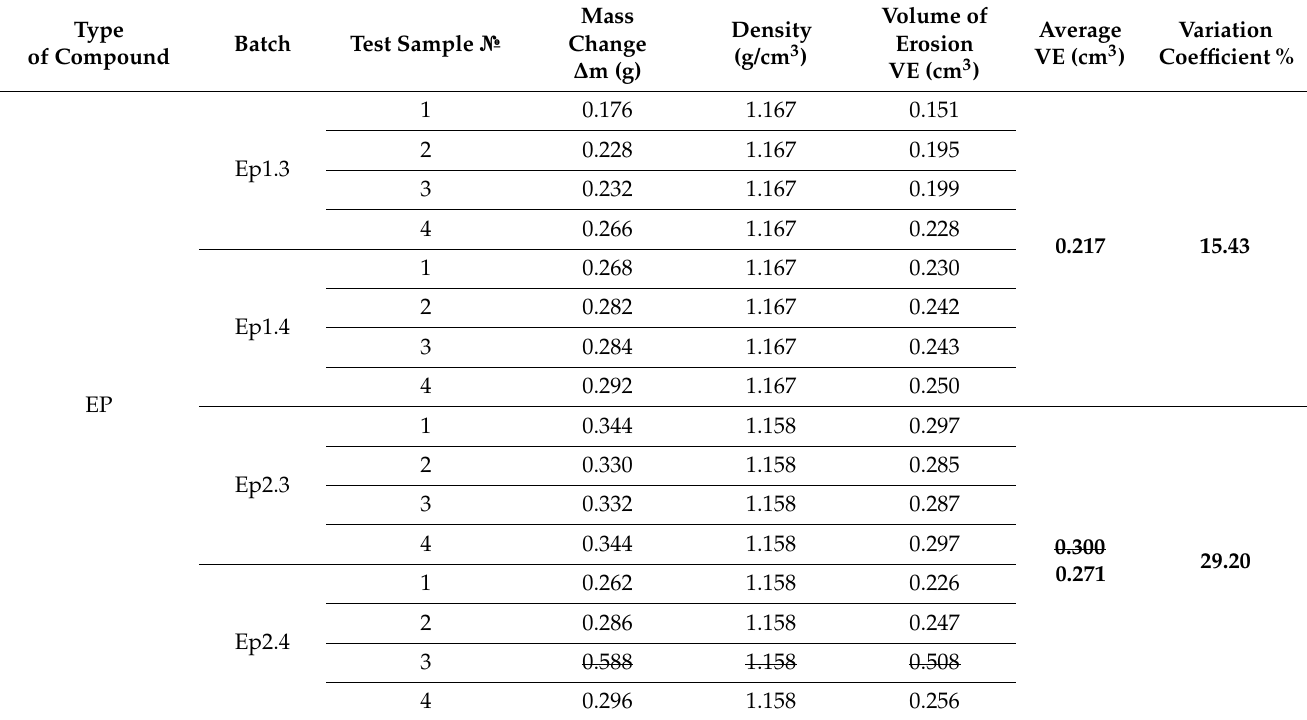
Table A2. Wear of unfilled epoxy binder (EP) at 23 ◦ C at an impingement angle of 45 ◦ .